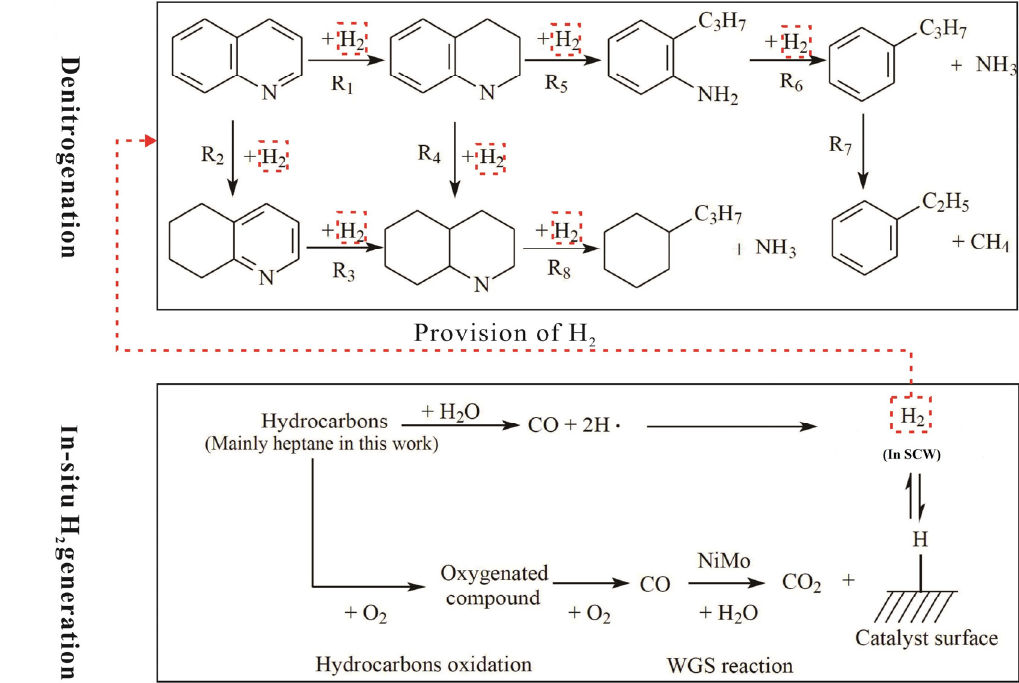
Figure 5. Mechanism of catalytic denitrogenation of quinolone in SCW. Reproduced with permission from [70], published by Elsevier Limited, 1995.